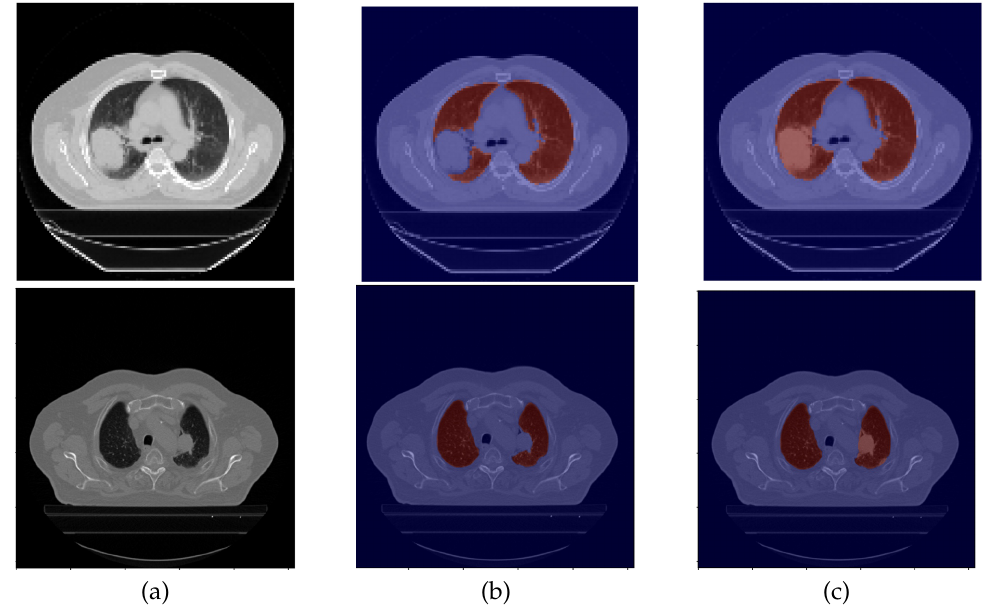
Figure 2. Example of a data correction. From left to right: ( a ) CT original image; ( b ) the original lung mask, which excludes the nodule; ( c ) and the corrected lung mask, which includes the